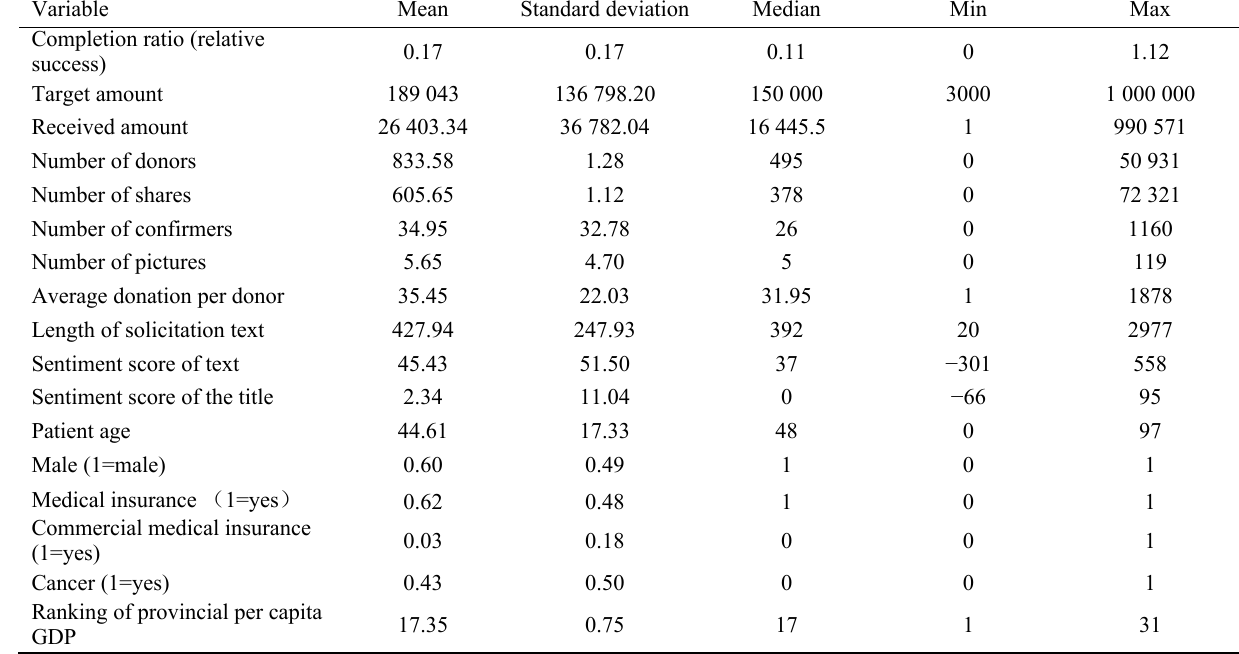
Table 3 Descriptive statistics of campaign characteristics (N=41